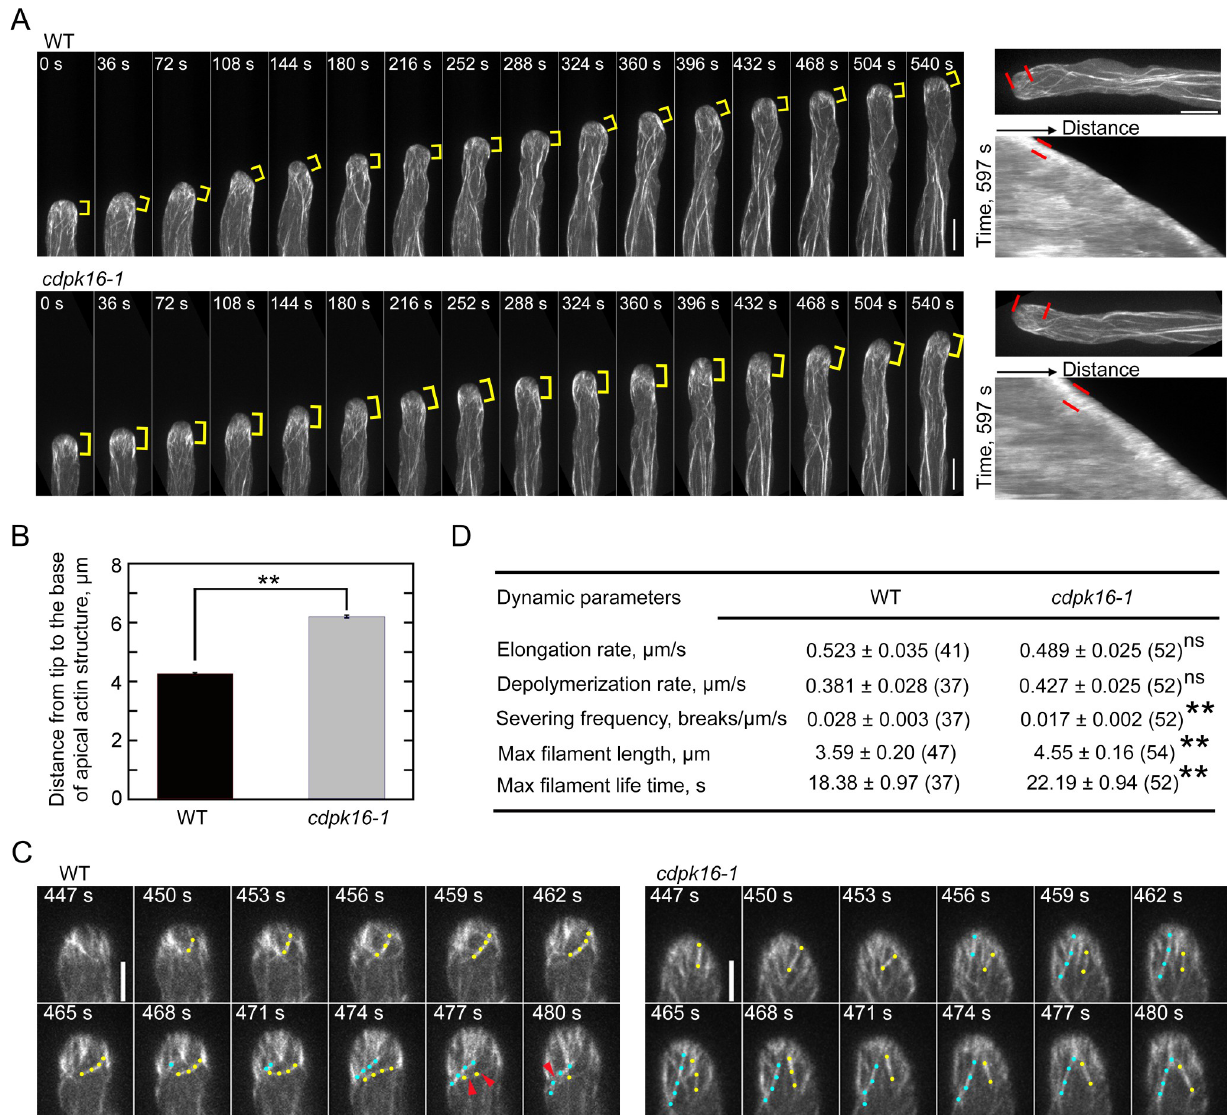
Fig 1. Actin dynamics is reduced in cdpk16 pollen tubes. ( A ) Time-lapse images of actin filaments decorated with Lifeact-eGFP in growing WT and cdpk16-1 pollen tubes. Yellow brackets indicate the region occupied by membrane-originated actin filaments. The right panels are Kymograph analyses of the growing WT and cdpk16-1 pollen tubes shown in the left panel. The region occupied by the membrane-originated actin filaments is marked by 2 red lines. Bar = 10 μ m. ( B ) Quantification of the width of the region occupied by membrane-originated actin filaments in WT and cdpk16-1 pollen tubes. Data are presented as mean ± SE, ** P < 0.01 (Student’s t test). More than 400 time points from 10 pollen tubes were measured. Numerical data underlying this panel are available in S1 Data. ( C ) Time-lapse images of actin filaments at the apical region in WT and cdpk16-1 pollen tubes. Apical actin filaments are indicated by different colored dots. The severing events of actin filaments are indicated by red arrows. Bar = 5 μ m. ( D ) Dynamic parameters of apical actin filaments in WT and cdpk16-1 pollen tubes. Data are presented as mean ± SE, with the number of filaments in parentheses. NS, no significant difference, ** P < 0.01, (Student’s t test). WT, wild